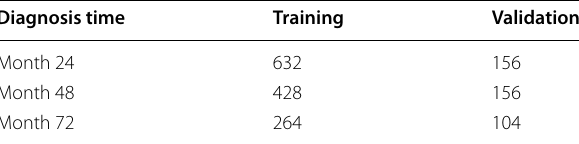
Table 4 Number of observations for training and validation of diagnosis MLPs